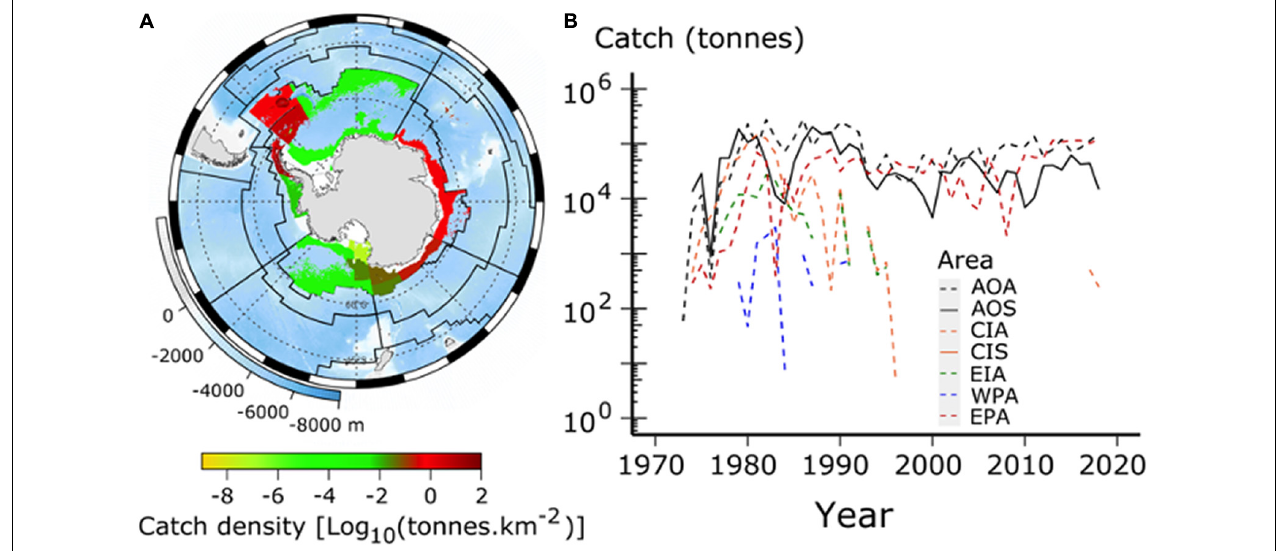
FIGURE 5 | Catches of Antarctic krill ( Euphausia superba ) from 1970 to 2018, derived from the Commission for the Conservation of Antarctic Marine Living Resources (CCAMLR) Statistical Bulletin 2019. (A) Shows total accumulated catch density over this period as log10 (catch density in tons.km − 2 ) (see colour ramp at bottom). Background is ocean depth in meters (bottom left legend on map). Black lines show boundaries of Marine Ecosystem Assessment for the Southern Ocean (MEASO) areas as depicted in Figure 1 . Grey lines show a graticule (see Grant et al., 2021). (B) Shows time series of catches of Antarctic krill in each of the MEASO areas (log10 transformed Y -axis). Legend embedded in plot indicates line types for each area, where acronyms relate to MEASO sectors (first two letters) and zones (last letter). Sectors are Atlantic (AO), Central Indian (CI), East Indian (EI), West Pacific (WP), and East Pacific (EA). Zones are Antarctic (A), Subantarctic (S), and Northern